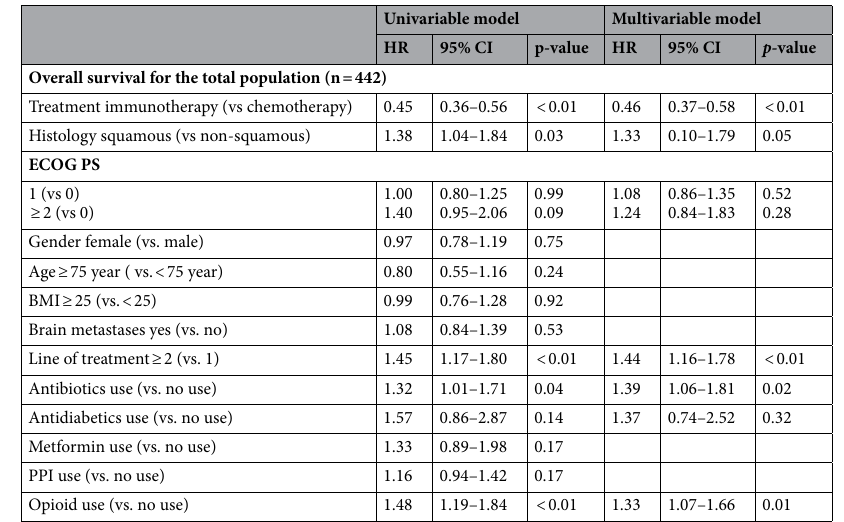
Table 3. Univariable and multivariable model for overall survival in the total population. Abbreviations: ECOG PS, Eastern Cooperative Group performance status; BMI, body mass index PPI, proton pump inhibitor; HR, Hazard ratio; CI, confidence interval.